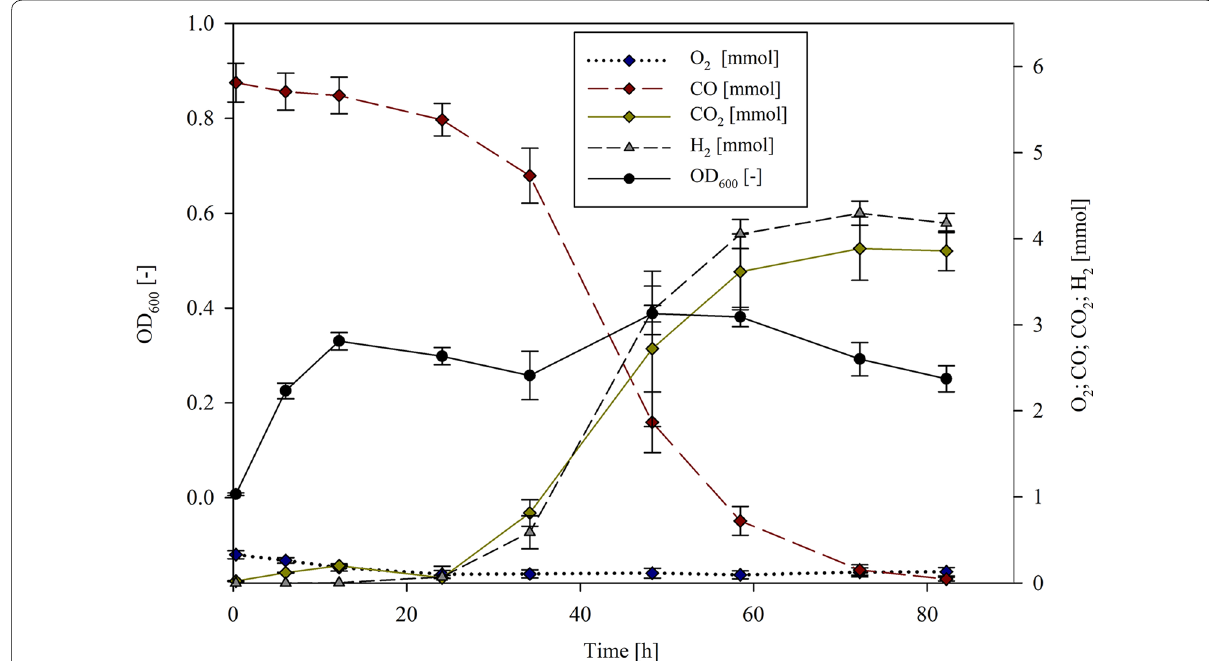
Fig. 3 Growth curve and gas composition during the cultivation of P. thermoglucosidasius DSM 6285 with the combined superior parameters (55 °C, pH 7.0, addition of 0.08 mM FeSO 4